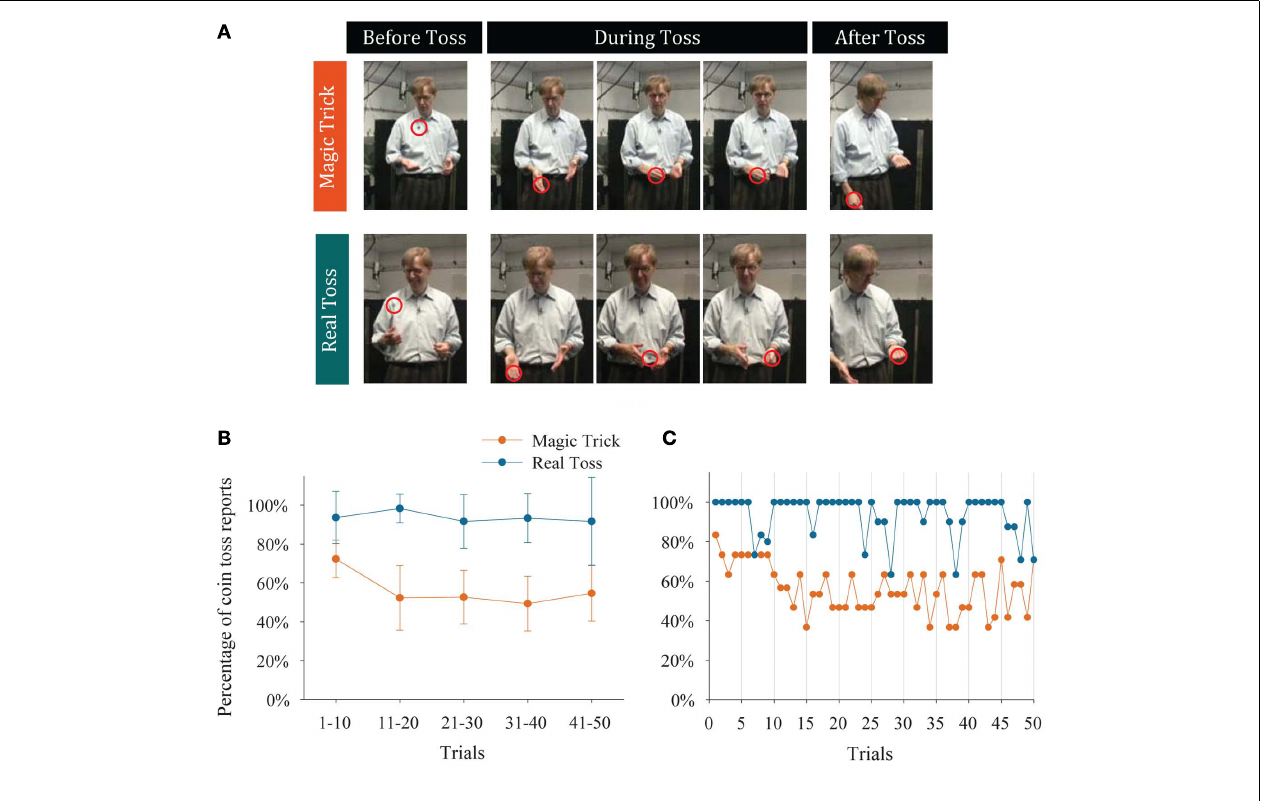
Percentage of coin toss reports, per 10-trial block, per experimental condition. Error bars represent SEM across subjects ( N = 9). (C) Percentage of coin toss reports, trial by trial, per experimental condition ( N = 9